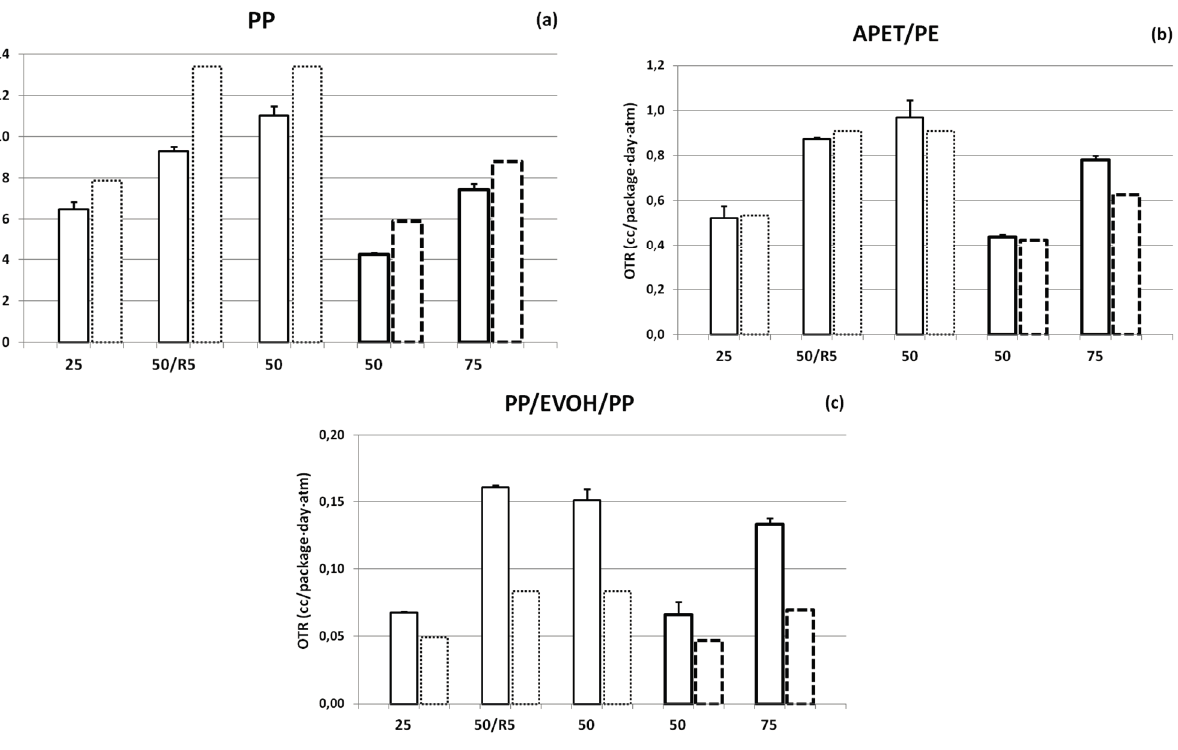
Figure 10. OTR results expressed in cc/package·day·atm. Bars in thin and thick lines represent the measured OTR of the trays from the thin and thicker ( a ) PP; ( b ) APET/PE; and ( c ) PP/EVOH/PP material variants, respectively; bars in thin and thicker dotted lines (····and --- ) represent the theoretical OTR based on Equation (4) for the thin and thicker sheet variants,